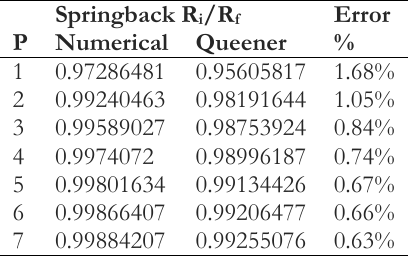
Table 8. The error in the Queener and FEM results for t = 2